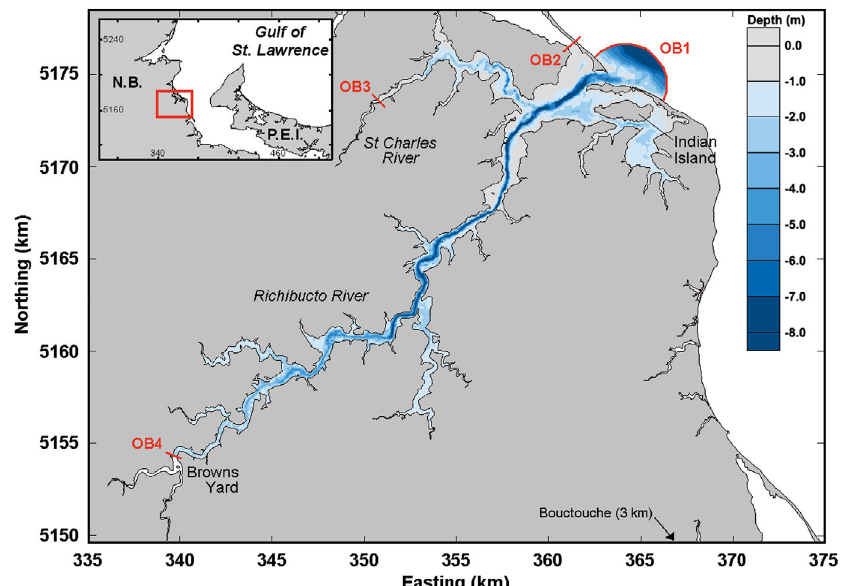
Fig. 1. Richibucto Estuary (New Brunswick [N.B.], Atlantic Canada) showing the bathymetry used in the numerical model. OB: open boundary used for modelling; P.E.I.: Prince Edward